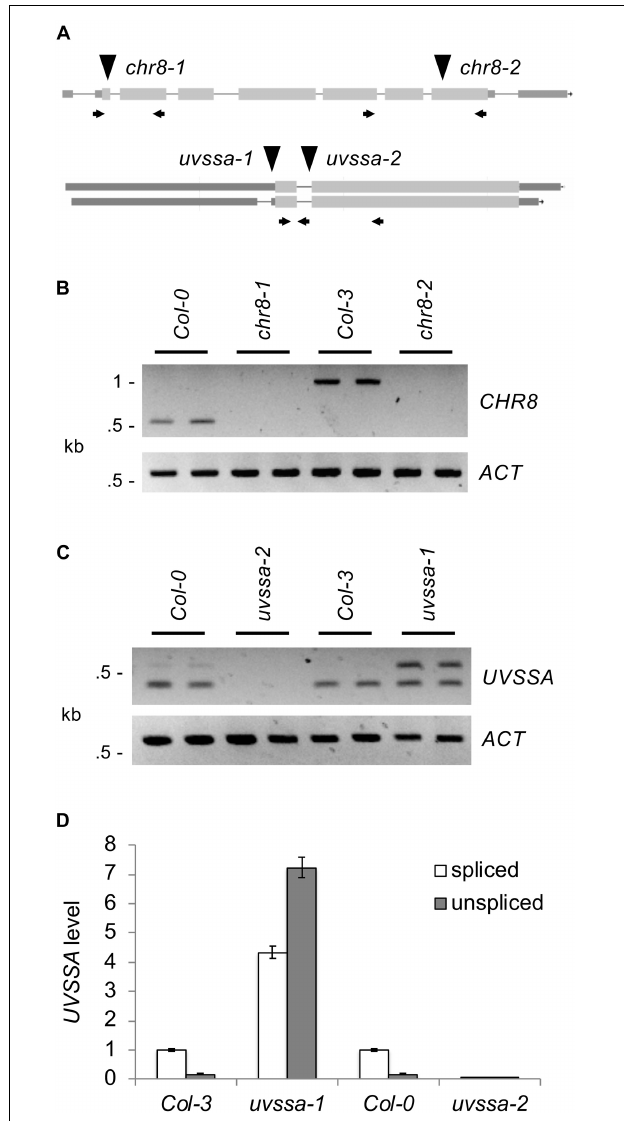
FIGURE 3 | Analysis of CHR8 and UVSSA alleles. (A) Map of CHR8 ( At2g18760 ) and UVSSA (At3g61800) genes. Lines indicate introns and boxes exons, with coding regions shaded light gray and untranslated regions dark gray. For CHR8 , transcript At2g18760.4 is shown because it is the best match to light grown seedling RNA-Seq data in JBrowse (Buels et al., 2016). For UVSSA , both known transcripts, At3g61800.1 (above) and At3g61800.2 (below), are shown. The location of T-DNA alleles chr8-1 (SALK_000799), chr8-2 (SAIL_273_G11), uvssa-1 (SAIL_58_C12), and uvssa-2 (SALK_061538) are indicated with triangles. Arrows indicate primers used in RNA analysis. (B) Semi-quantitative RT-PCR analysis of CHR8 and ACTIN expression in chr8-1 and chr8-2 and their respective wild-type backgrounds, using CHR8 primers flanking each allele. (C) Semi-quantitative RT-PCR analysis of UVSSA and ACTIN expression in uvssa-1 and uvssa-2 and their respective wild-type backgrounds, using UVSSA primers in the first and second coding exons. For (B,C) , two technical replicates per sample are shown. (D) qPCR analysis of spliced (primers in first coding exon and spanning exon 1–2 junction) and unspliced (primers in first coding exon and following intron) UVSSA level. UVSSA level was normalized using EF1 α and expressed as relative to Col-3 spliced product level. Error bars indicate SE of three technical